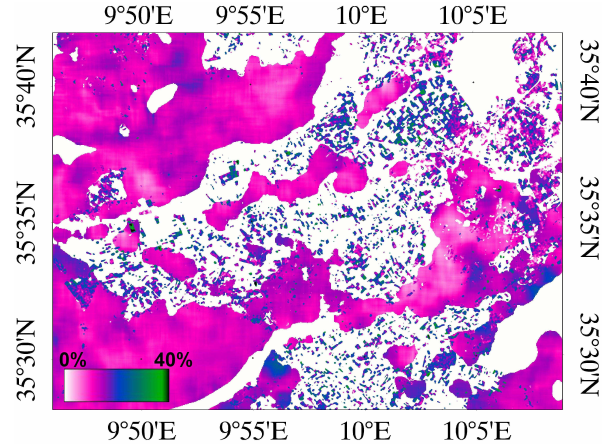
Fig. 11. Example of moisture mapping, showing soil moisture es- timations for fields in the “olive tree” and “wheat” classes of land use on 7 March